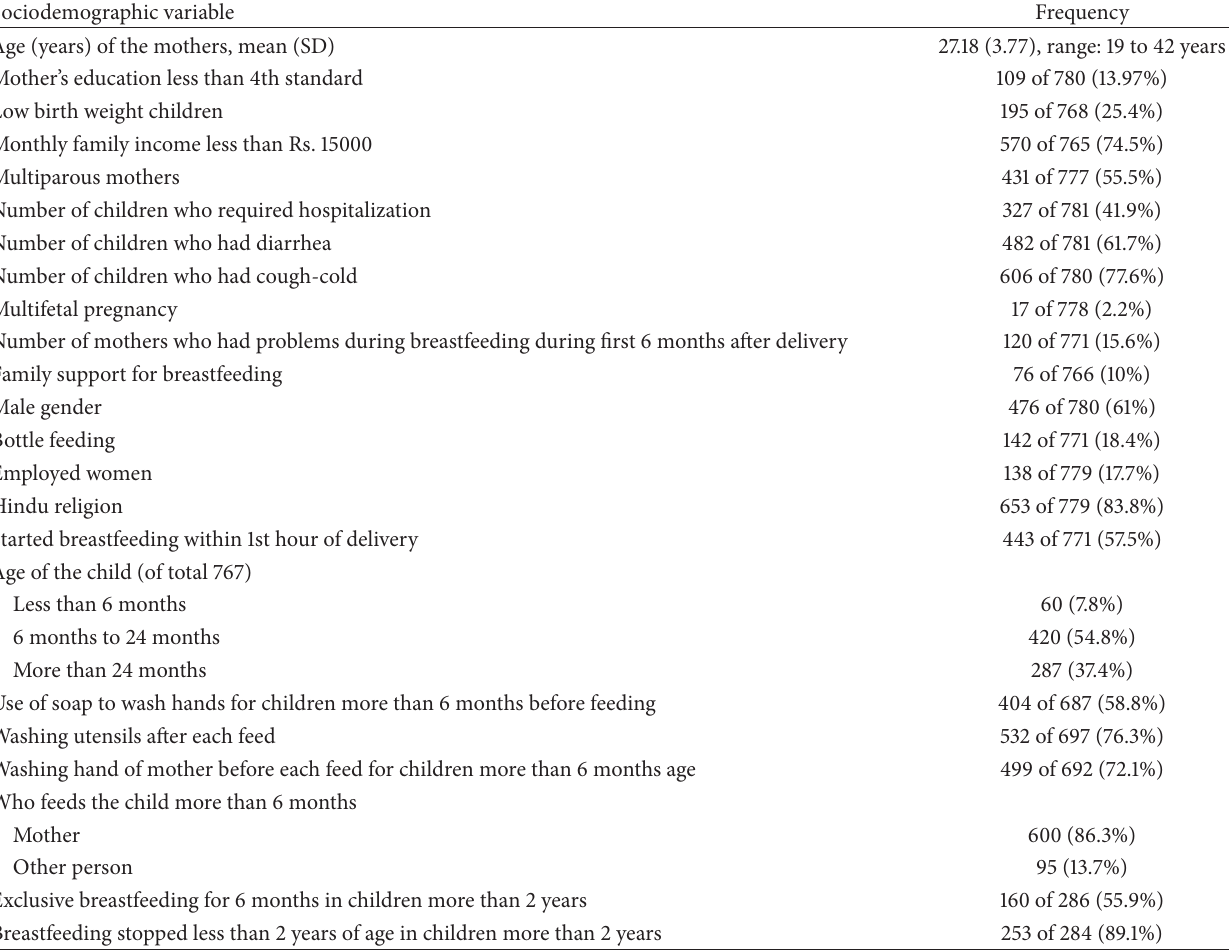
Table 1: Sociodemographic